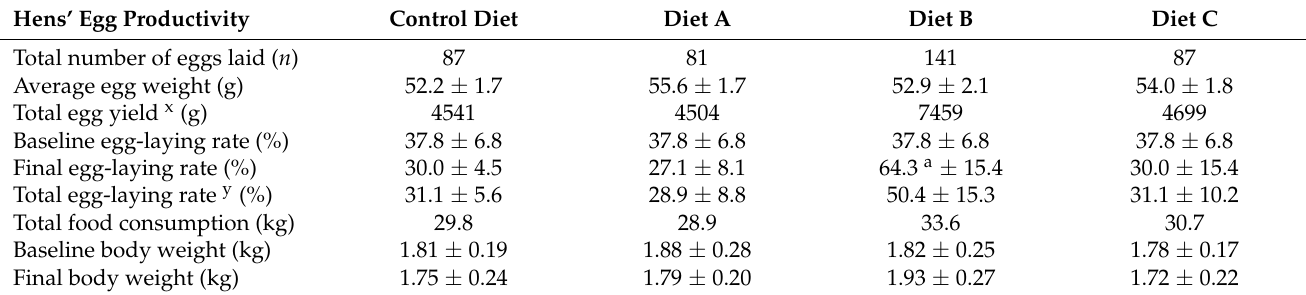
Table 3. Summary of egg productivity over a 4-week period of aging White Leghorn hens ( n = 10/group) fed a commercial corn/soymeal poultry diet (Control), the same diet supplemented with soy germ to increase the content of isoflavone glycosides (diet A), the same diet with added milled soy germ pasta containing predominantly isoflavone aglycons (diet B) and the same diet with conventional pasta lacking isoflavones (diet C).